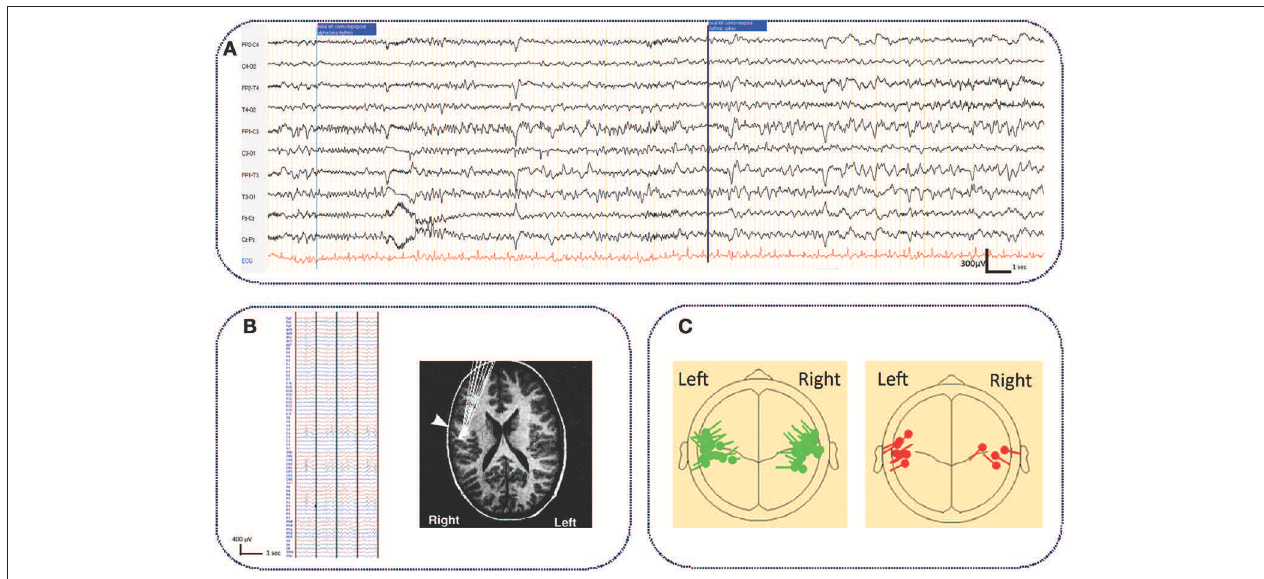
FIGURE 1 | Typical ictal aspect on standard EEG in ECTS and electrical source imaging of IES in typical and atypical ECTS. (A) Typical aspect of ECTS seizure characterized by initial focal low amplitude alpha-beta activity (9–14Hz), gradually increasing in amplitude and decreasing in frequency to the alpha band (6–8Hz), followed by rapid rhythmic spikes. Longitudinal bipolar montage, electrodes positioned according to the international 10/20 system. Band pass (0.53–70Hz), notch filter (50Hz) (personal data). (B) Typical right centro-temporal IES on normal background activity recorded with HD EEG [averaging referential montage, band pass (0.53–70Hz)] and electrical source imaging (HD EEG) of IES with tangential dipoles located along the central sulcus with the negative pole situated in the posterior mid-temporal or central regions [ adapted with authorization from Bourel-Ponchelet al. ( 83)]. (C) Comparison of typical (in green) and atypical generator (in red) of IES in ECTS and Atypical Benign Partial Epilepsy, respectively. Compared to ECTS, in Atypical Benign Partial Epilepsy, IES dipoles have a preferential posterior orientation [reproduced with authorization from Kim et al. (84). Averaged EEG spike dipole analysis may predict atypical outcome in Benign Childhood Epilepsy with Centrotemporal Spikes (BCECTS). Brain Dev. 38, 903–908]